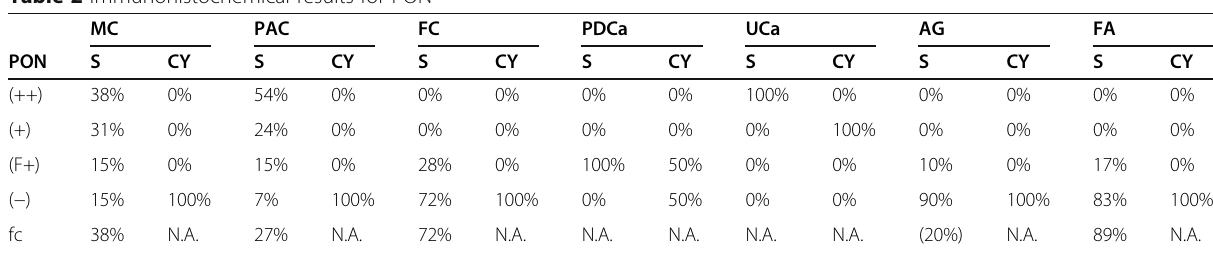
Table 2 Immunohistochemical results for